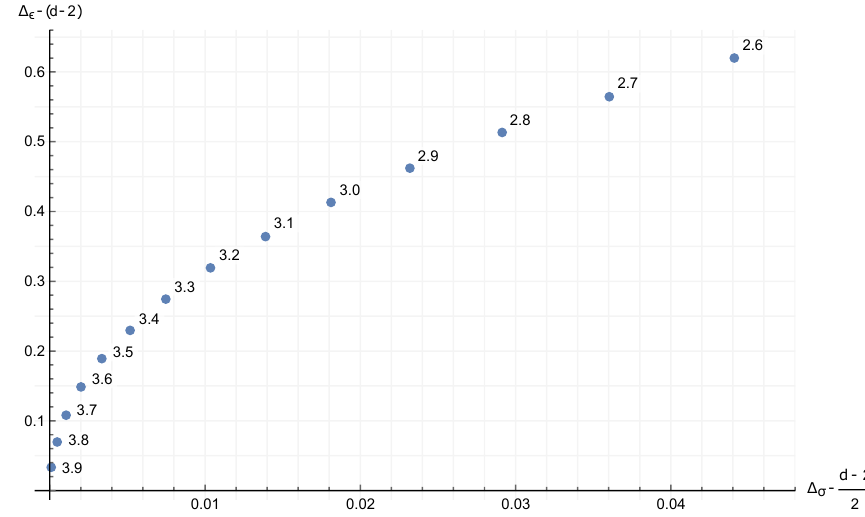
Figure 1 . The final points of the navigator search, presented in the space of anomalous dimensions. The point d = 3 . 95 is excluded for